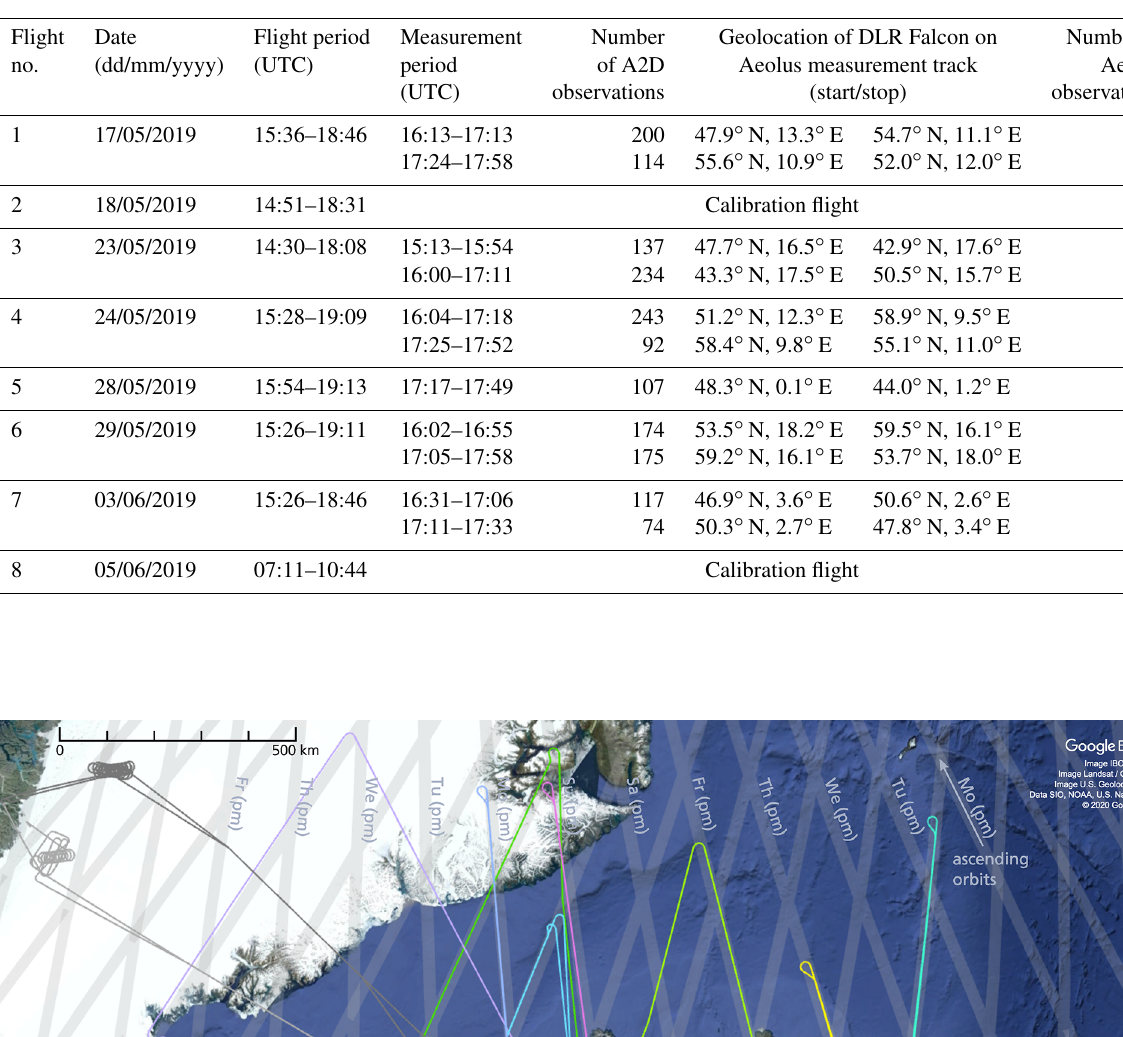
Table 1. Overview of the research flights of the Falcon aircraft in the frame of the AVATARE campaign in May/June 2019 and the wind scenes performed with the A2D along the Aeolus measurement track.